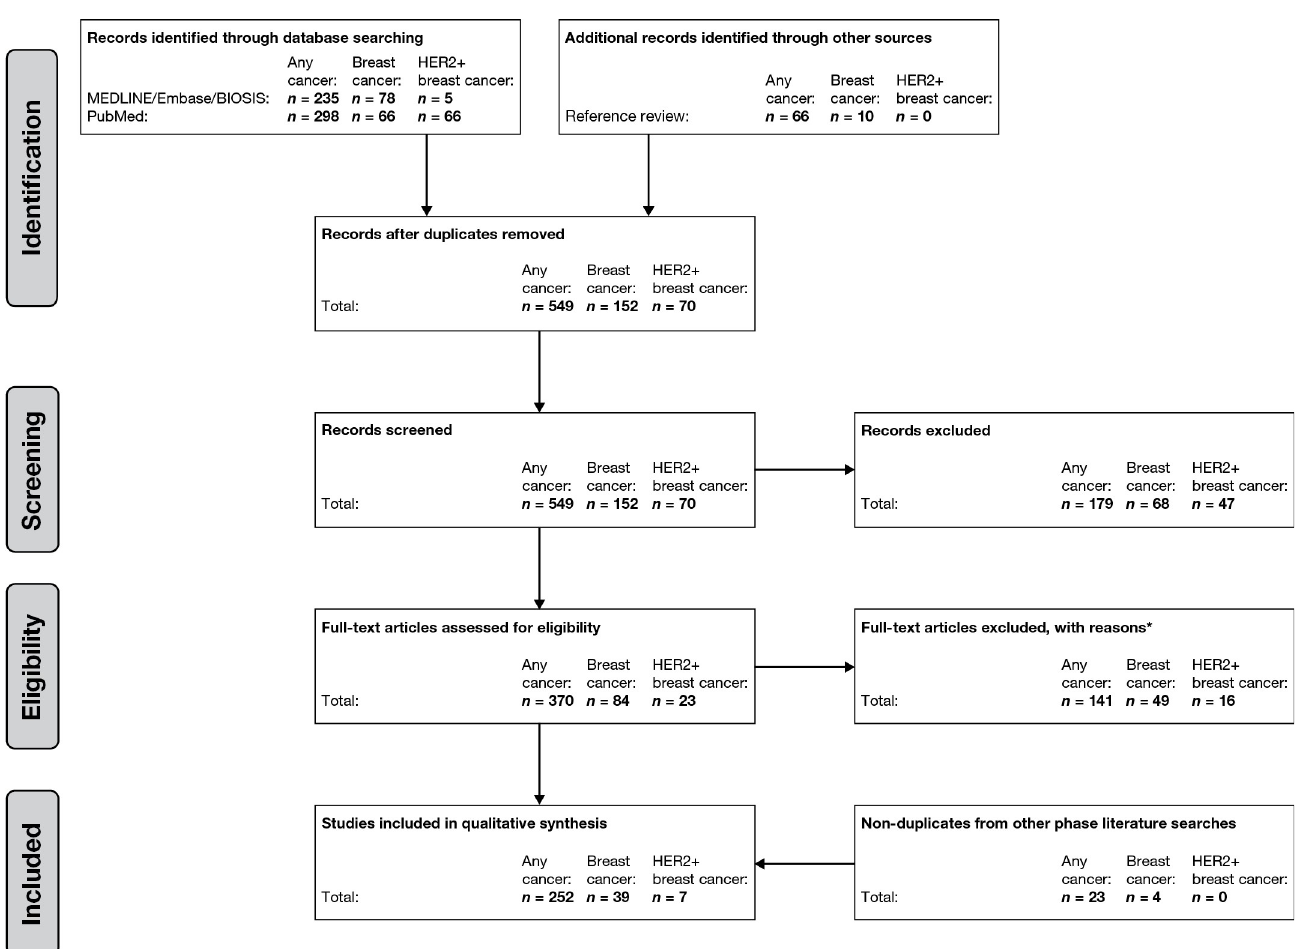
Fig 1. PRISMA flow diagram for “any cancer”, “breast cancer”, and “HER2+ breast cancer”. � Reasons for exclusion: Any cancer: 28 abstract terminal documents; 1 guideline; 2 expert panel; 1 focus on cancer screening; 1 non-English; 72 no comorbidity index used; 5 focus not on comorbidity; 13 not focused on patients with cancer or patient population not well-defined; 16 not primary literature (review); 1 date range out of scope; 1 not available from publisher. Breast cancer: 43 no mention of comorbidity index; 2 focus on treatment decision; 2 non-English; 2 not primary literature. HER2+ breast cancer: 13 no mention of comorbidity index; 3 not focused on HER2+ breast cancer. HER2+ human epidermal growth factor receptor-2-positive, PRISMA Preferred Reporting Items for Systemic Reviews and Meta-analysis.